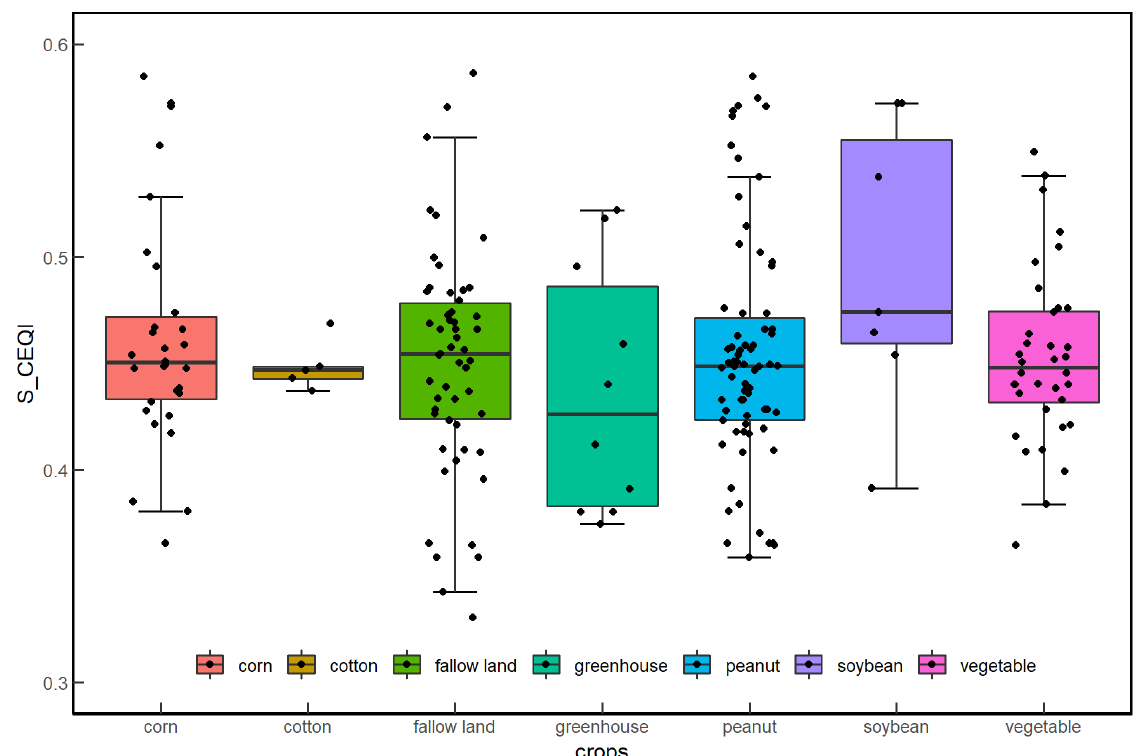
Figure 12. Box plots of integrated EQI using S_CEQI of the 219 sample points .